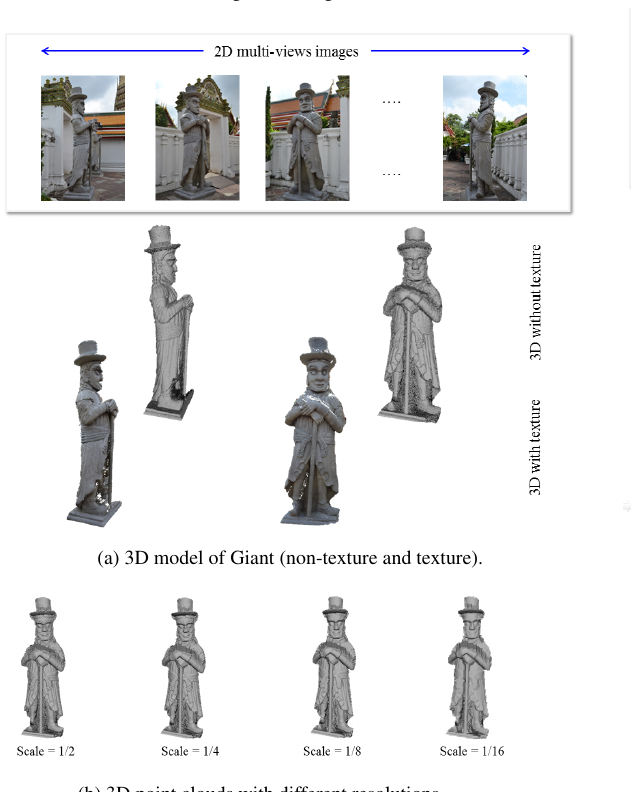
(b) 3D point clouds with different resolutions. Figure 9: Pagoda